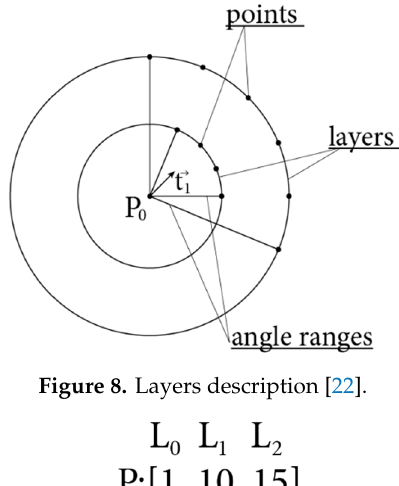
Figure 9. Layers parameters: P—number of points, A—angle ranges, L—layers radii [22].